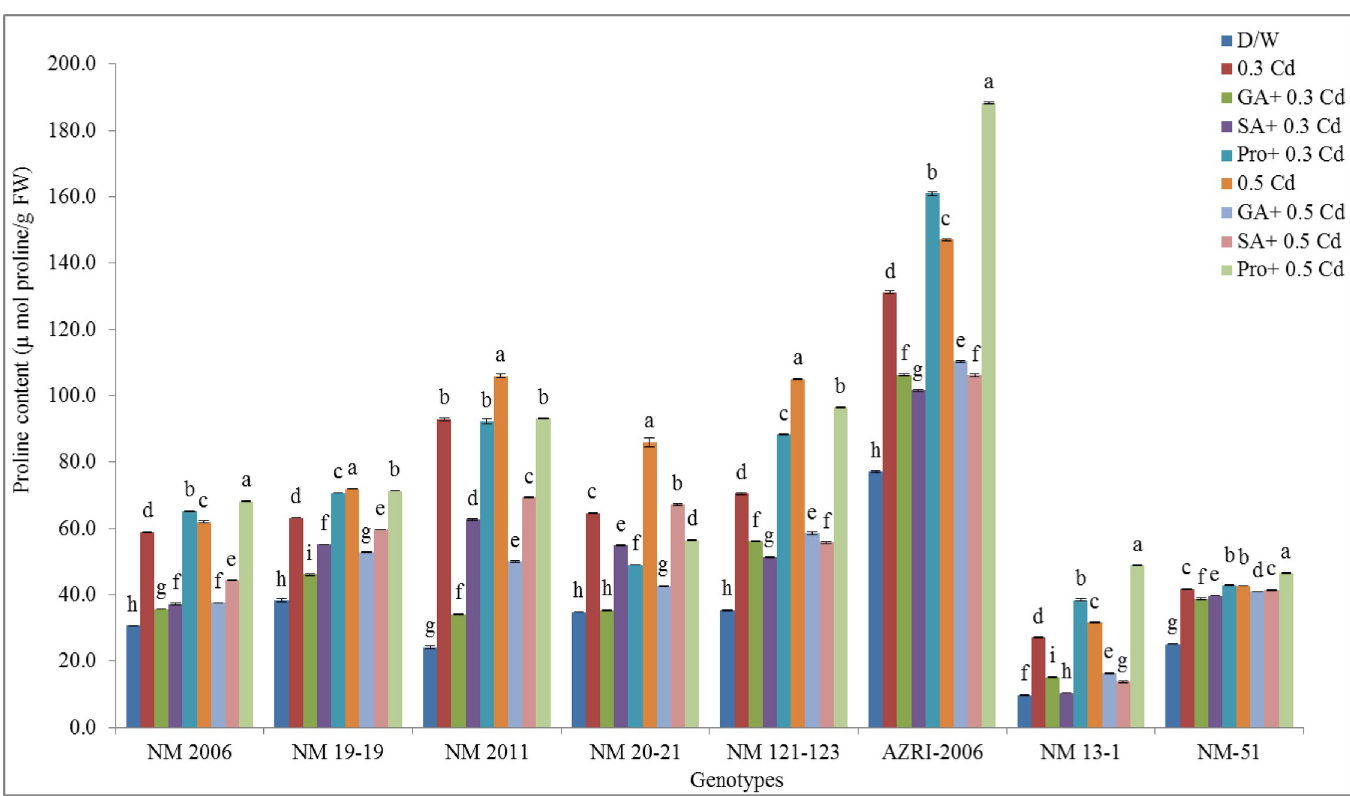
Fig 15. Mean proline contents of mung bean grown under Cd and pretreatments of GA 3 , SA and proline prior to Cd.